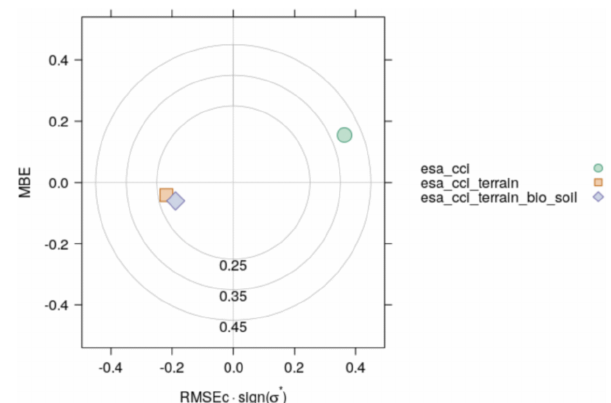
Figure A4. Target diagram showing the performance of our soil moisture predictions. The x axis represents the unbiased RMSE (variance units of the error), and the y axis represents the MBE. This figure shows that our soil moisture predictions using terrain pa- rameters (esa_cci_terrain) and the predictions using terrain parame- ters and bioclimatic and soil type classes (esa_cci_terrain_bio_soil) show lower error levels when compared with field data (from the ISMN) than the ESA-CCI soil moisture product